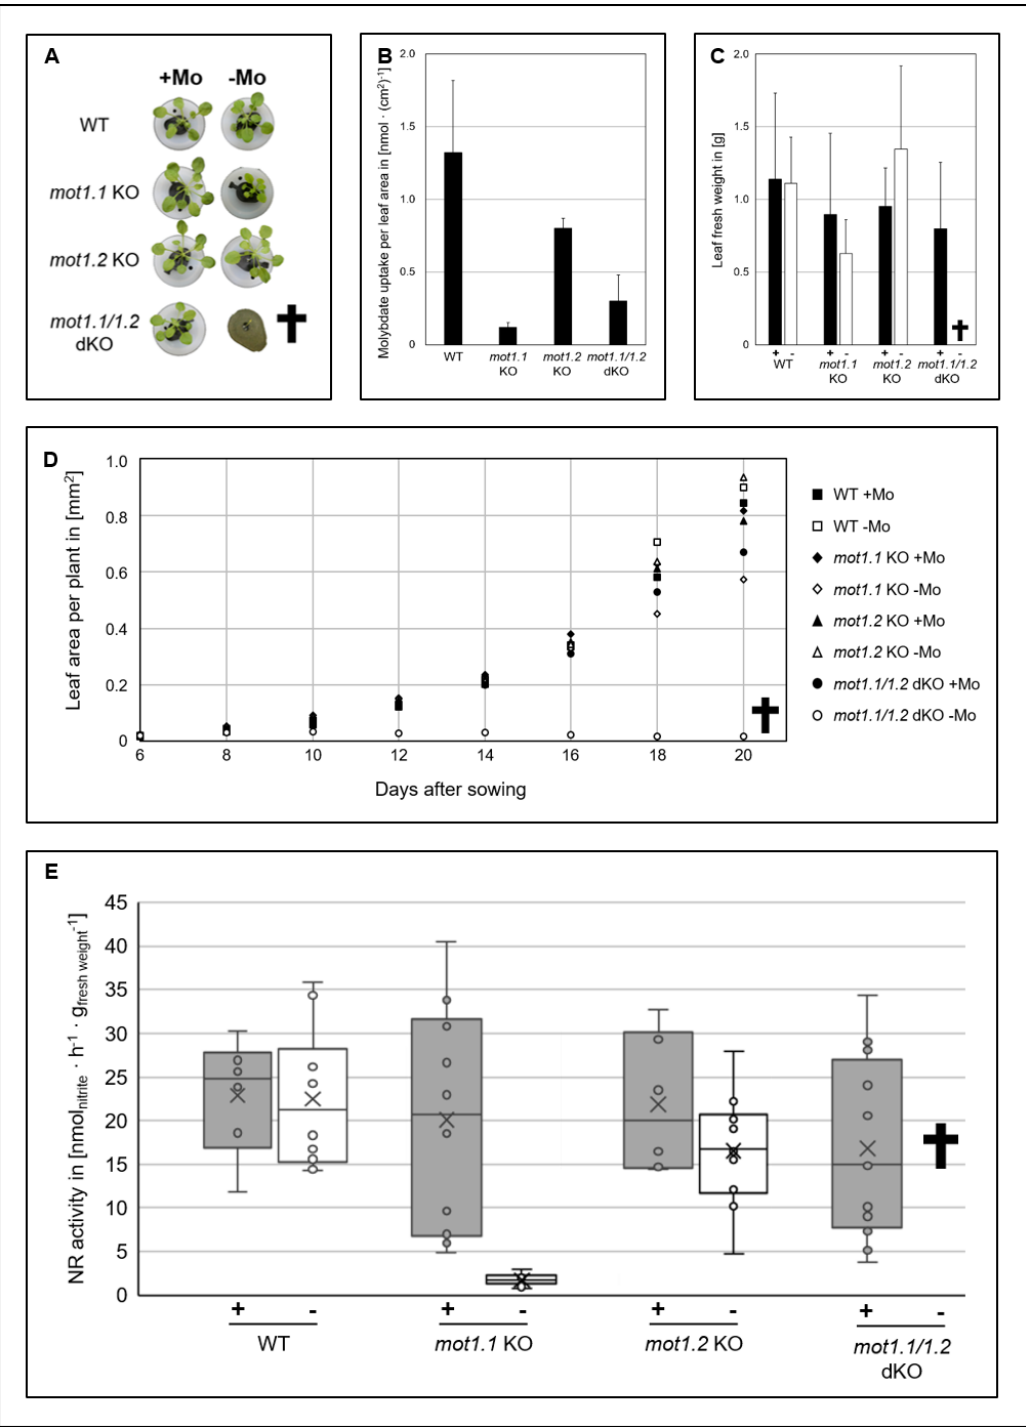
Figure 3. Impact of molybdate deprivation on macroscopic and molecular phenotype on A. thaliana mot1 KO lines. Arabidopsis KO lines were grown hydroponically under molybdate availability (+Mo) and molybdate deprivation (−Mo) conditions. ( A ) Macroscopic phenotype 34 days after sowing. ( B ) Molybdate uptake per plant normalised to leaf area. ( C ) Rosette fresh weight 60 days after sowing. ( D ) Leaf area per plant during growth period of 20 days. ( E ) NR activity of plants grown under molybdate availability (+) and deprivation (− ). Boxplot: X = mean, middle line = median. † = mot1.1 mot1.2 dKO died under – Mo conditions, not allowing the performance of further analysis. When grown under molybdate deprivation, mot1.1 KO showed a pale green leaf col- ouration with partially necrotic areas (Figure 3A) and a reduced growth rate (Figure 3D),